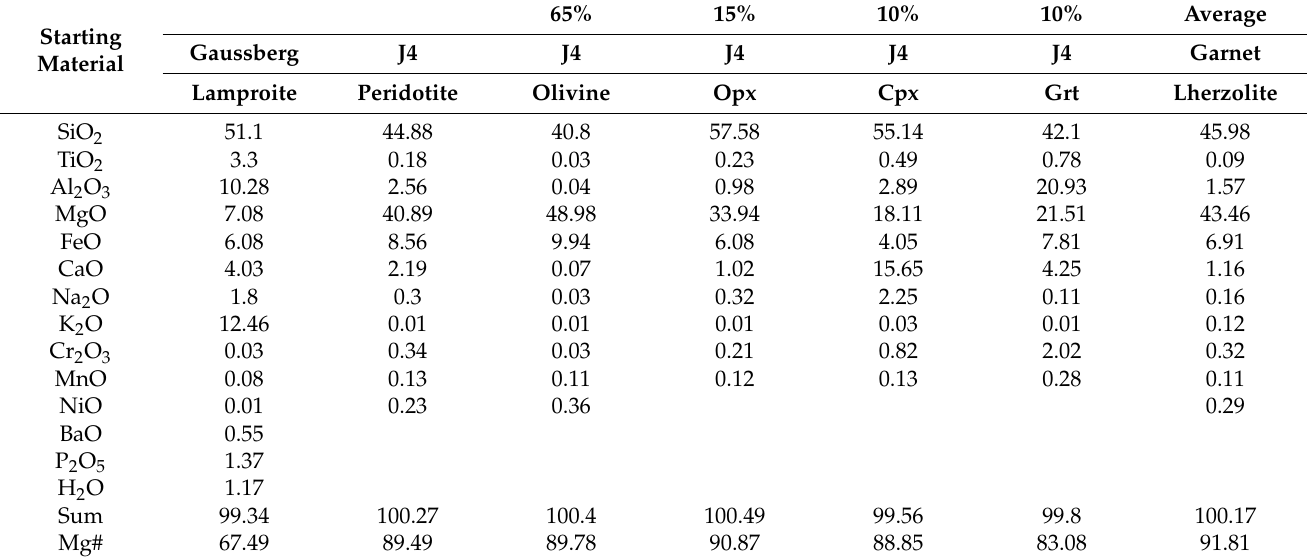
Table 2. Compositions of starting materials: lamproite and peridotite and its constituent minerals. Starting